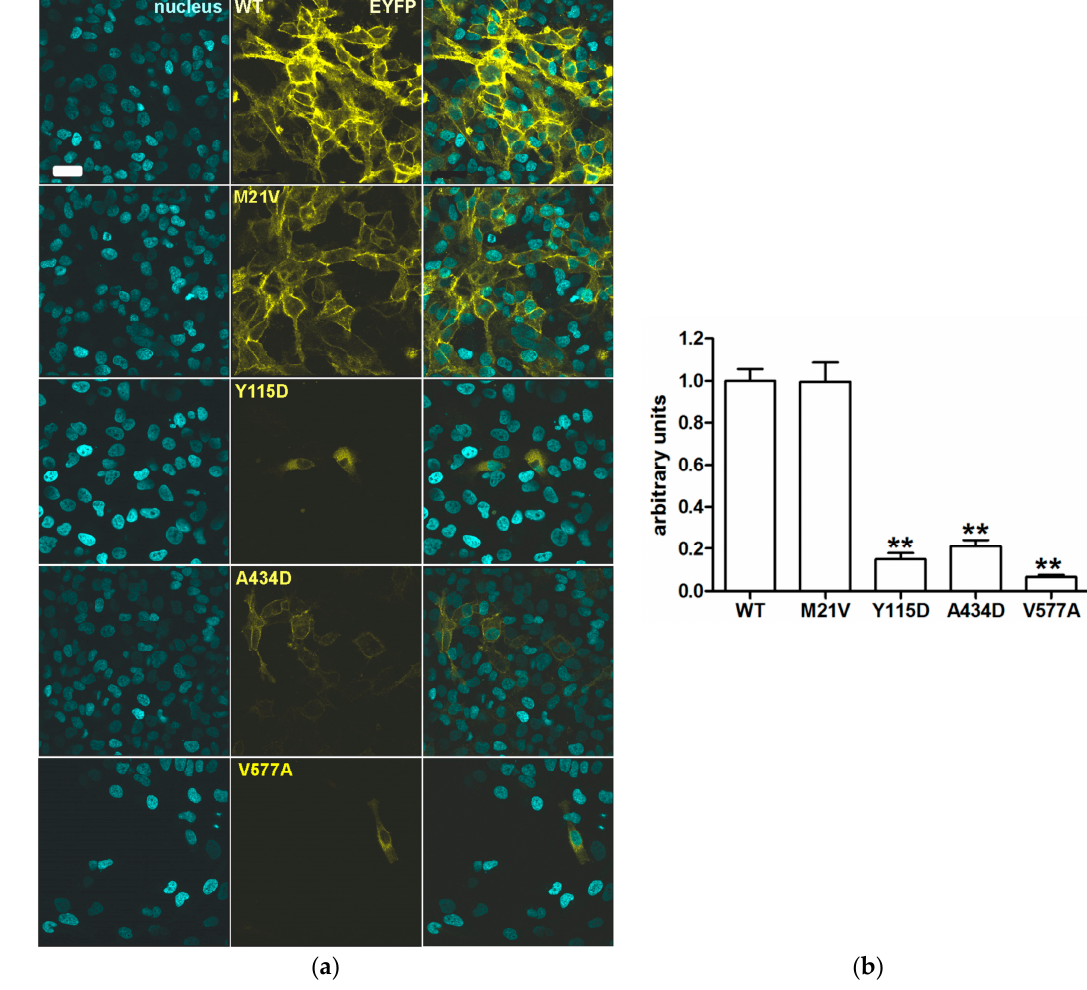
Figure 4. Total cellular levels of wild type pendrin and its variants in intact cells. ( a ) From left to right: nuclei counterstained with 4’,6-diamidino-2-phenylindole (DAPI, cyan), fluorescent signal of EYFP (yellow) fused to the C-terminus of the indicated pendrin variants expressed in HeLa cells for 72 h and corresponding merge image. Scale bar: 30 µm; ( b ) Wild type (WT) and mutated pendrin total expression levels expressed as fluorescence intensity (levels of grey) normalized for the cell density. Error bars represent SEM. n = 24, ** p < 0.01 compared to wild type, one-way ANOVA with Dunnet’s multiple comparison post-test. ( n ) refers to the number of imaging fields from 6 independent experiments.